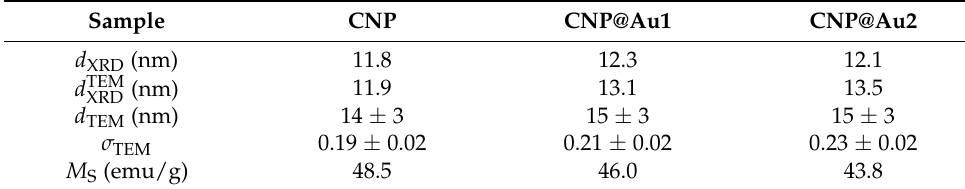
Table 1. The morphological and magnetic characteristics of the synthesized samples: d XRD , the average size of the maghemite cores that were extracted from the XRD data; d TEM and σ TEM , the mean diameter and the standard deviation of the MNPs that were extracted from the TEM histograms, respectively; M S , the saturation magnetization that was extracted from the hysteresis cycles. Sample CNP